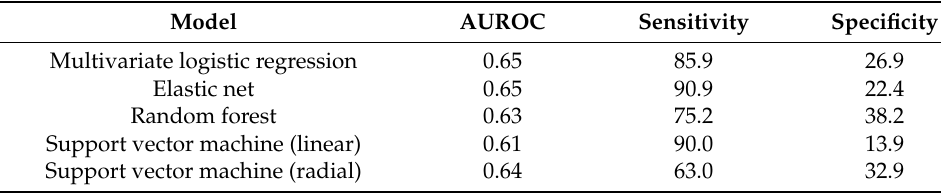
Table 2. Machine learning models’ performance.